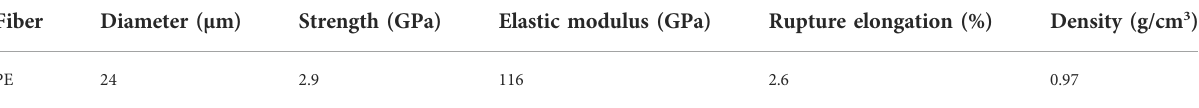
TABLE 2 Properties of PE fi